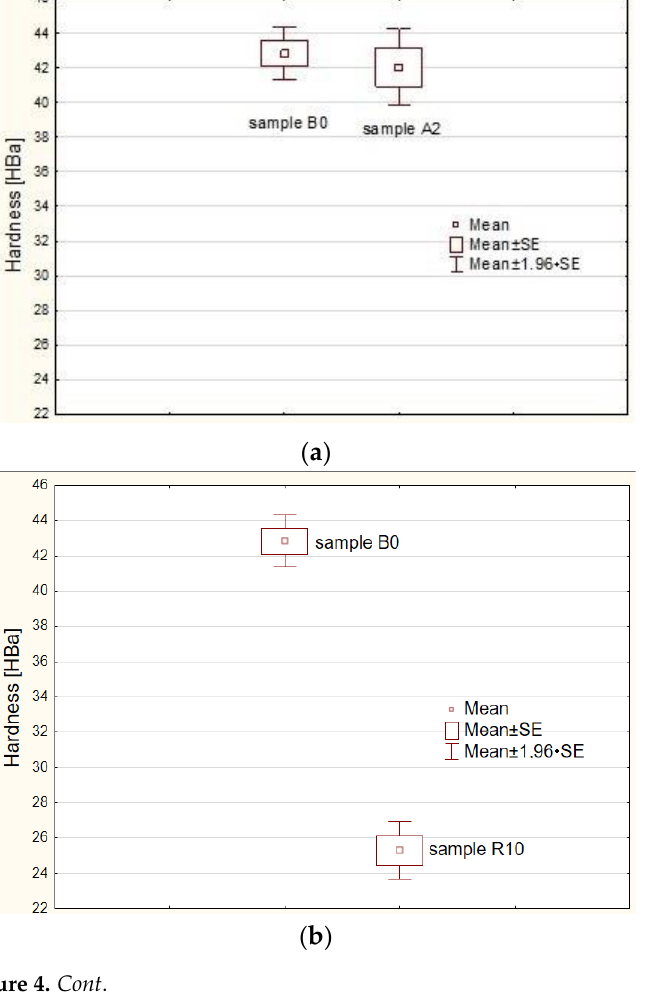
( c ) Figure 4. Frame-whisker chart for: ( a ) sample B0 versus sample A2; ( b ) sample B0 versus sample R10; ( c ) sample B0 versus sample R10A2, where: mean ± SE was mean ± standard error and mean ± 1.96 × SE was confidence interval for the mean. The obtained p -values of the pairwise comparisons (Table 4) and the box-whisker plots (Figures 4 and 5) showed that only the B0 and A2 samples did not differ significantly (the calculated p = 0.525898 is greater than the assumed p v = 0.05). There are significant statistical differences between the remaining samples.